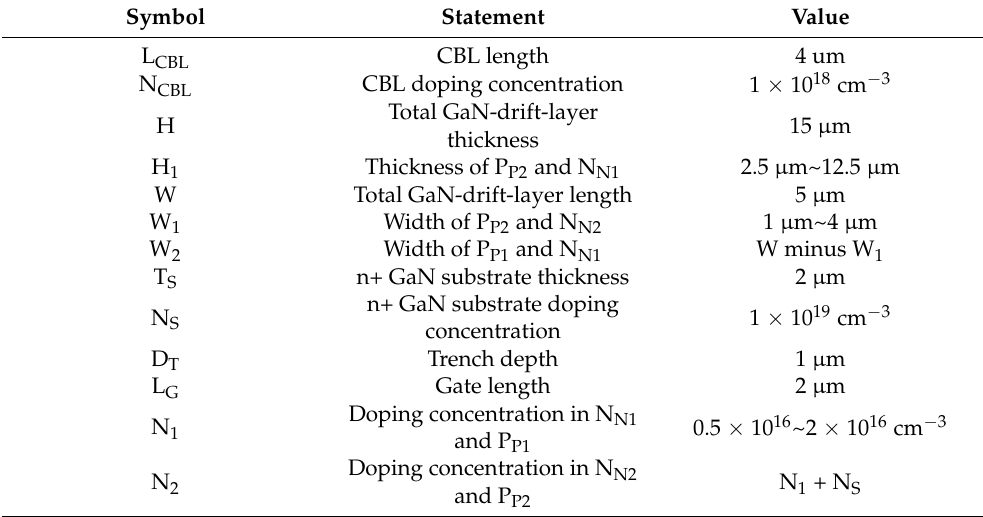
Figure 1. Schematic diagrams of ( a ) SJ-Trench CAVET and ( b ) SDS-Trench CAVET. Lines L1L2 and L3L4 indicate the vertical path along device center and CBL, respectively. Table 1. Key device parameters set in simulation [19].